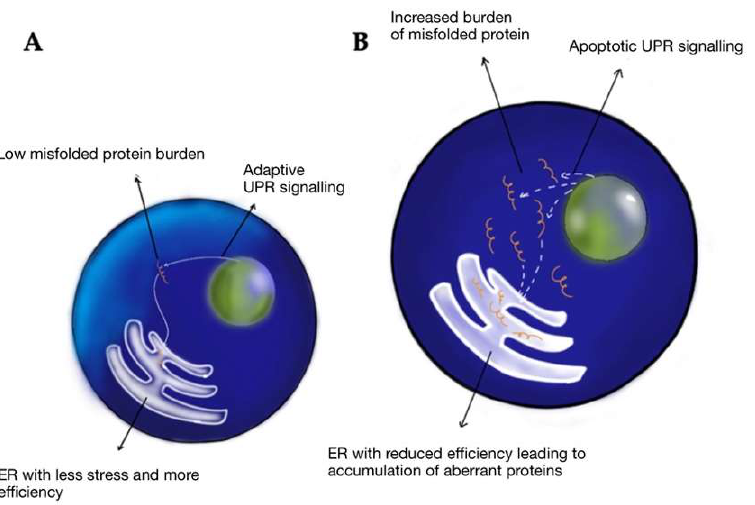
Figure 4. Response to misfolded proteins in the young ( A ) vs. aged ( B ) endoplasmic reticulum— when faced with misfolded proteins, young cells have low ER stress, higher chaperone efficacy, increased adaptive unfolded protein response (UPR) signaling, and increased stress tolerance. Hence, young ER is efficient in getting rid of misfolded proteins. In aged cells, due to reduced chap- erone activity, the misfolded cells are unable to clear and tend to accumulate, leading to a maladap- tive response as a relative increase in apoptotic UPR signaling vs. adaptive signaling, eventually leading to cell